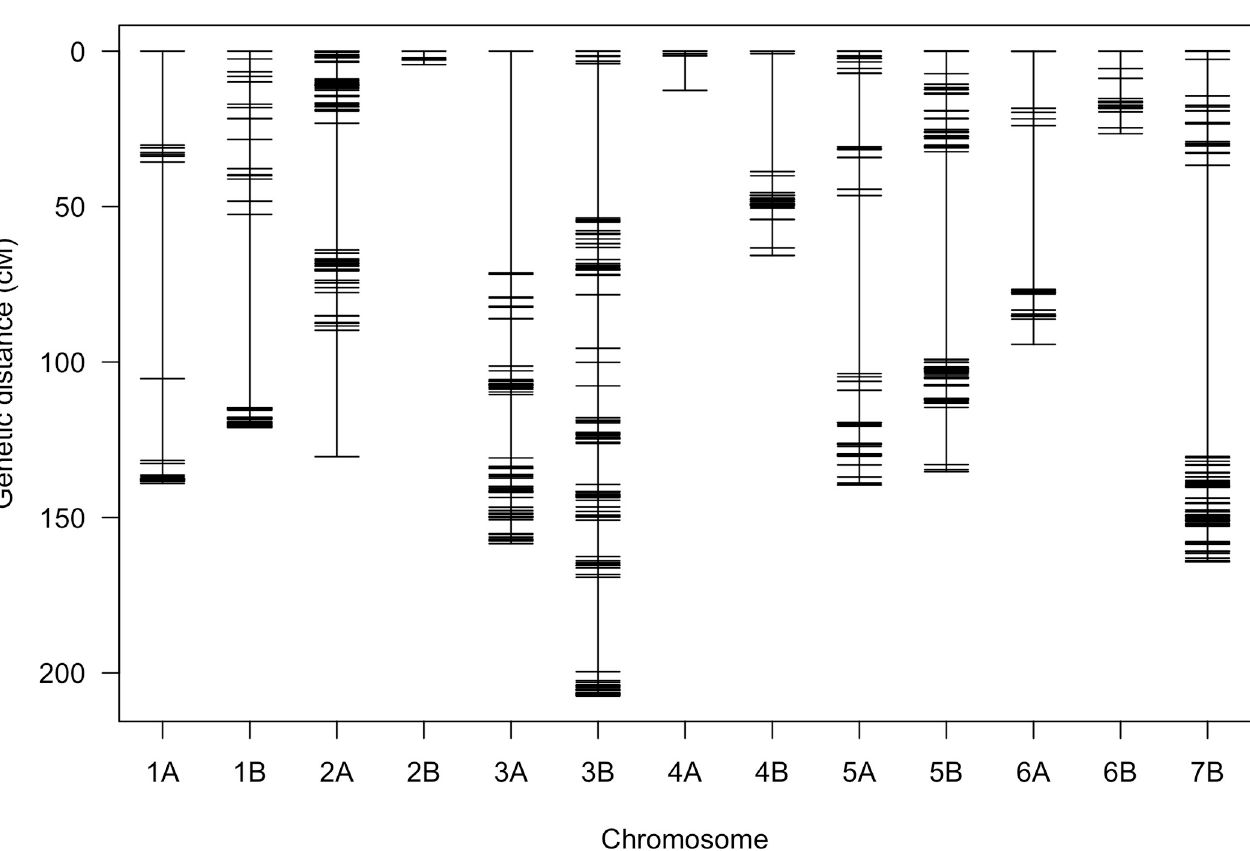
Fig 4. Genetic linkage map constructed from SNP markers derived from genotyping-by-sequencing in a recombinant inbred line population from a cross between Reichenbachii and DAKIYE.